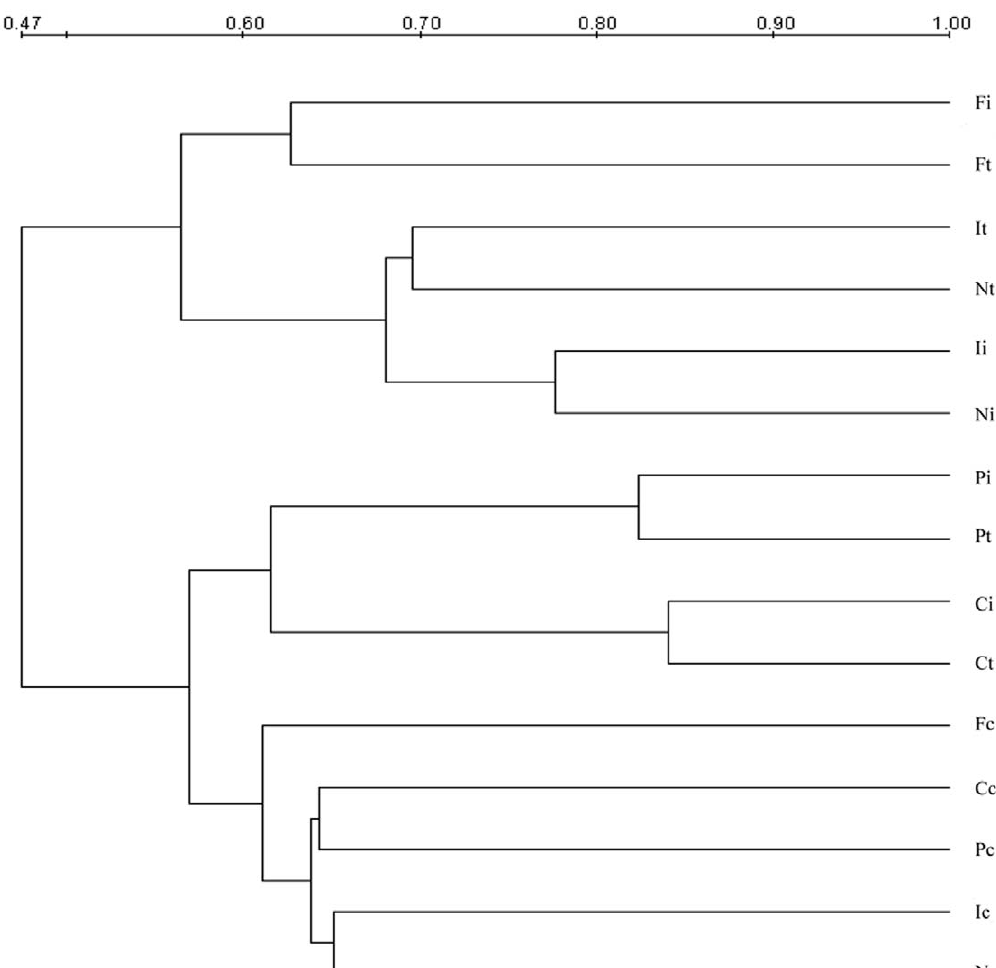
Figure 4. Cluster analysis of DGGE profiles of the mucosal samples. The dendrogram was constructed using UPGMA method.